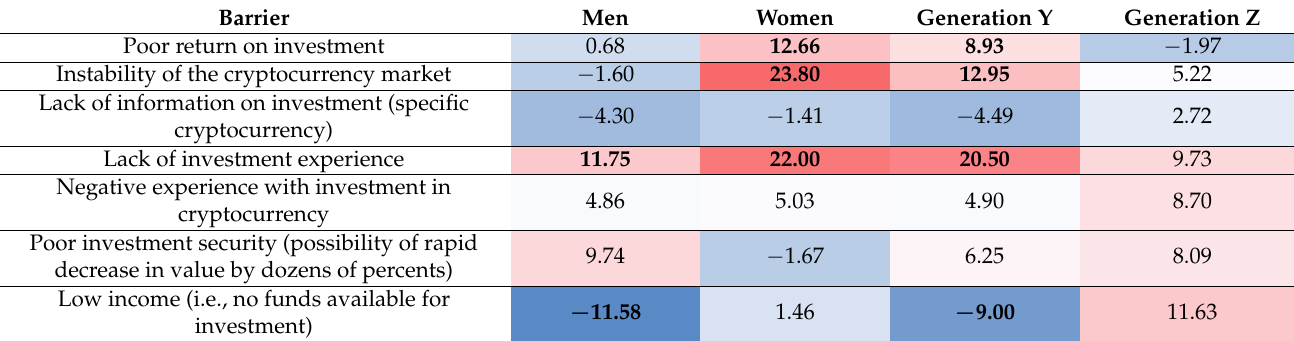
Table 3. The values below refer to the difference between respondents having and not having a tendency to take risks in percentage points, and to the given discouraging barrier. Positive values refer to by how many more percentage points there are respondents with a tendency to take risks who are discouraged by the given barrier, compared to those without such a tendency. A red-white-blue scale is selected for the entire table. Statistically significant values at the 5% significance are highlighted in